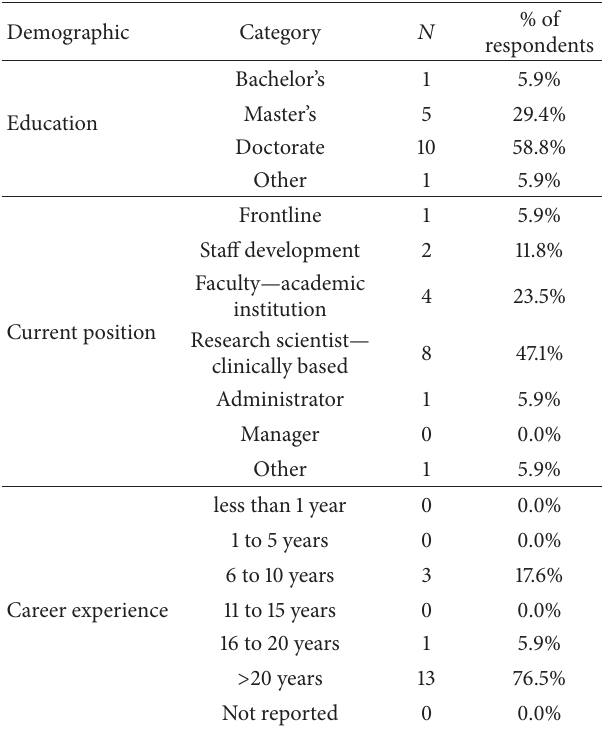
Table 3: Demographic breakdown of survey respondents (total 𝑁 =